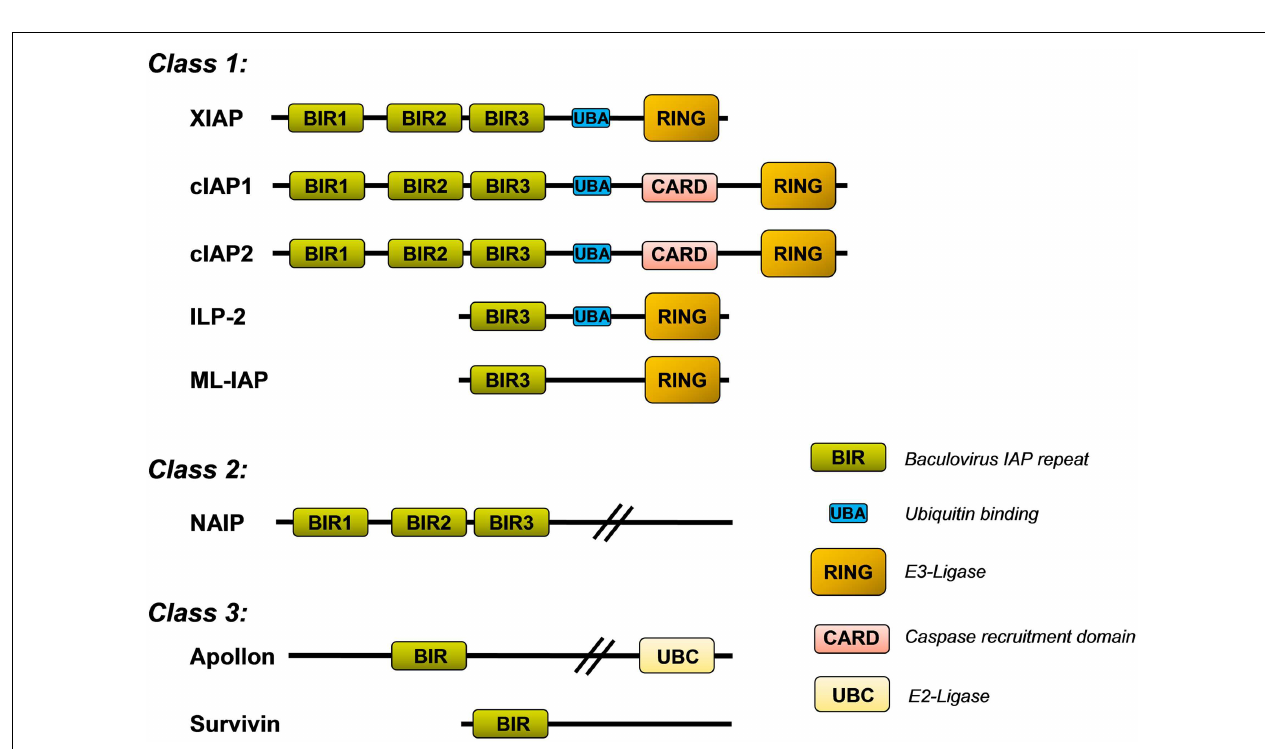
FIGURE 1 | Inhibitor of apoptosis protein (IAP) family . Shown is the structure of the eight mammalian IAPs with their known functional domains (description in the main text).